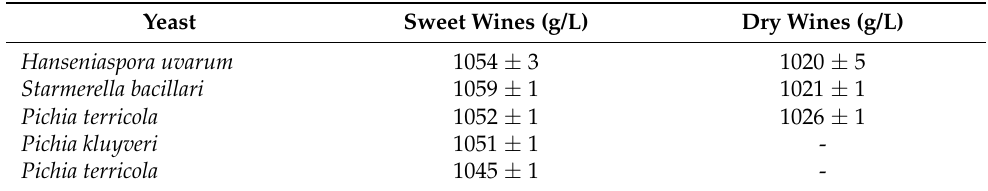
Table 1. Final density of wines fermented with the different non- Saccharomyces yeast strains isolated from Madeira wine